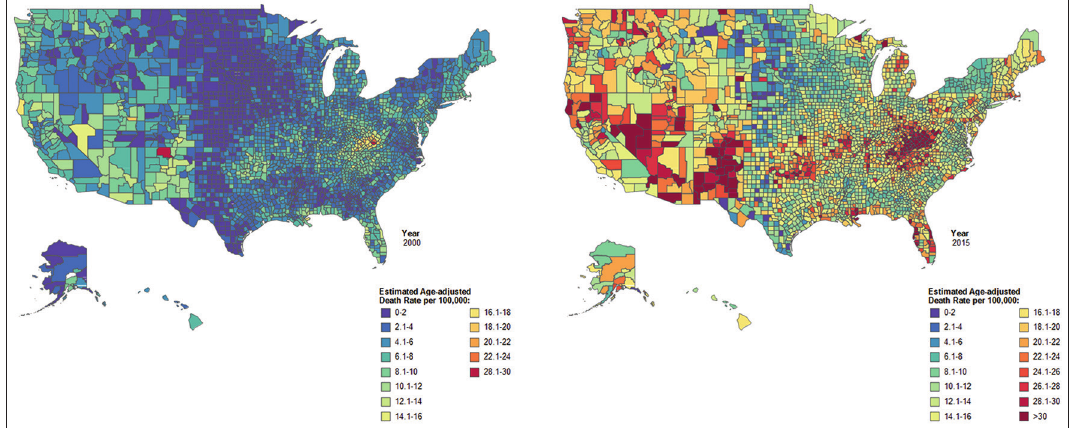
Figure 22. Estimated Age-Adjusted Drug Overdose Mortality Rates per 100,000 Population by County, United States, 2000 and 2015 Source: CDC/NCHS, National Vital Statistics System.